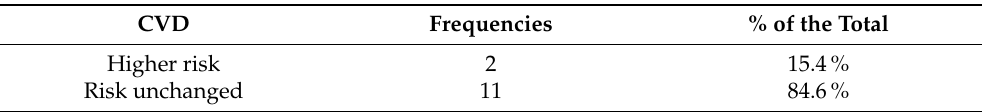
Table 3. Articles grouped by findings concerning cardiovascular disease (CVD) as a risk factor for biological complications of dental